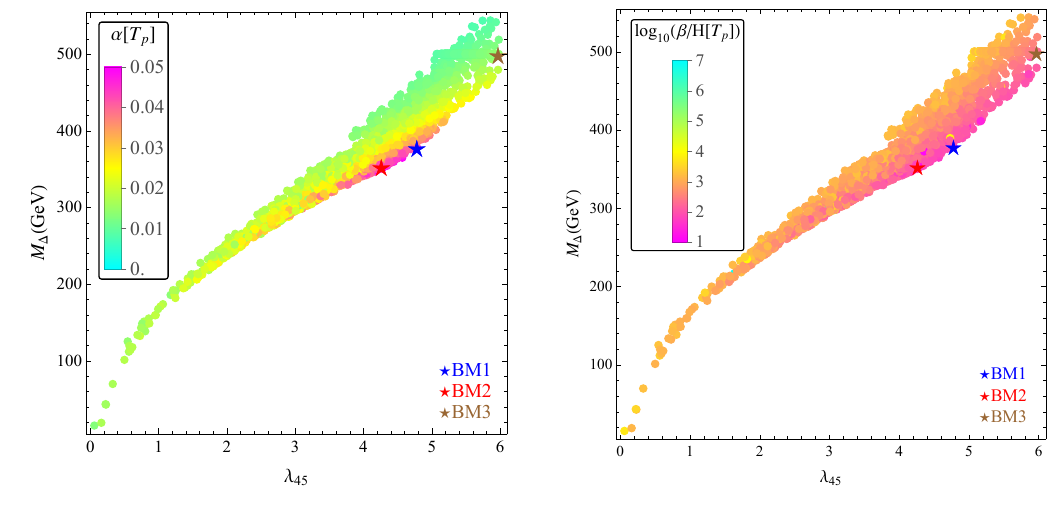
Figure 8 . Distributions of β/H [ T p ] and α for the four benchmark setups in section 3.5. Note that setup 2 is missing due to the decoupling of the